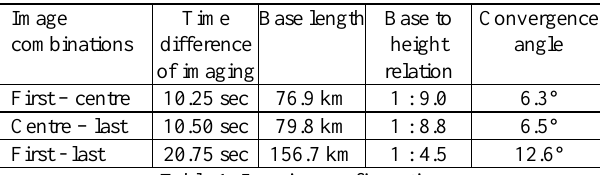
Table 1: Imaging configuration